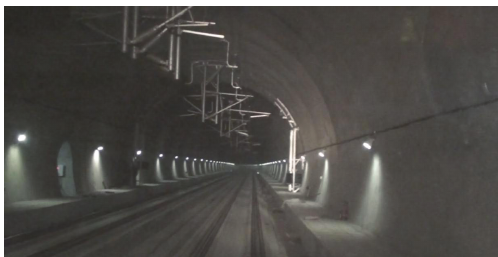
Figure 3: Tunnel